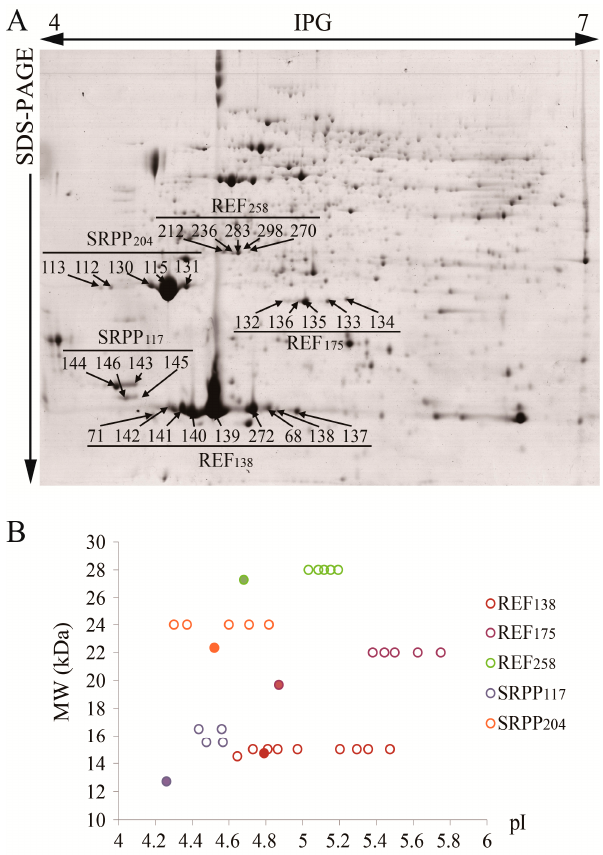
Figure 5. The REF and SRPP protein species. ( A ) The distributions of REF and SRPP protein species on a typical 2-DE gel of latex proteins from rubber tree RY 7-33-97 are presented; ( B ) The distribution of MW (molecular weight) and pI (isoelectric point) of each REF and SRPP protein species. The filled circles represent the theoretical MW and pI of each REF and SRPP protein, and the hollow circles represent the experimental MW and pI of each REF and SRPP protein species.